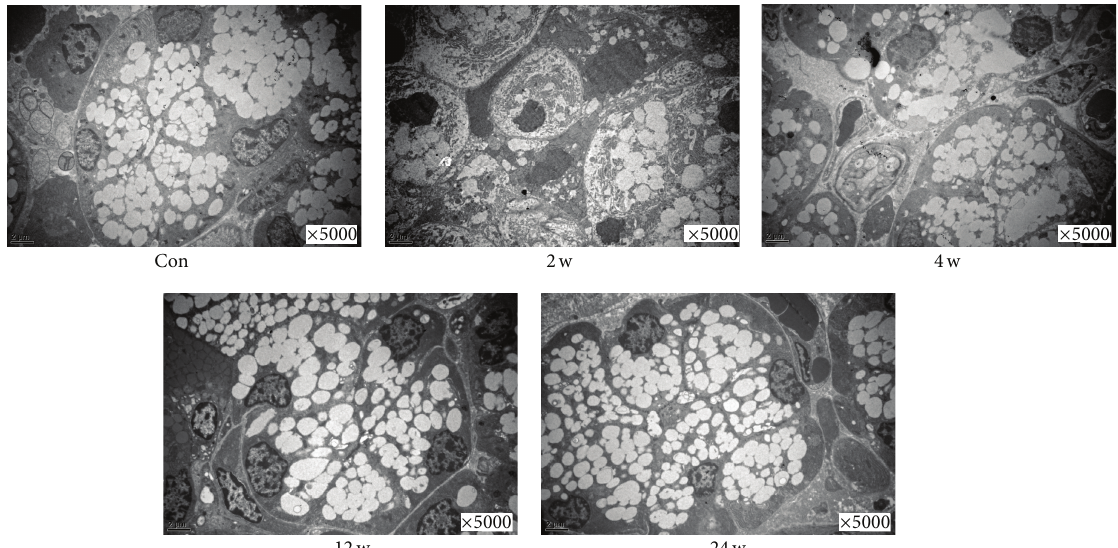
Figure 4: Effect of BTXA on the ultrastructure of transplanted submandibular glands. Control group and BTXA-treated groups (2, 4, 12, and 24 weeks).